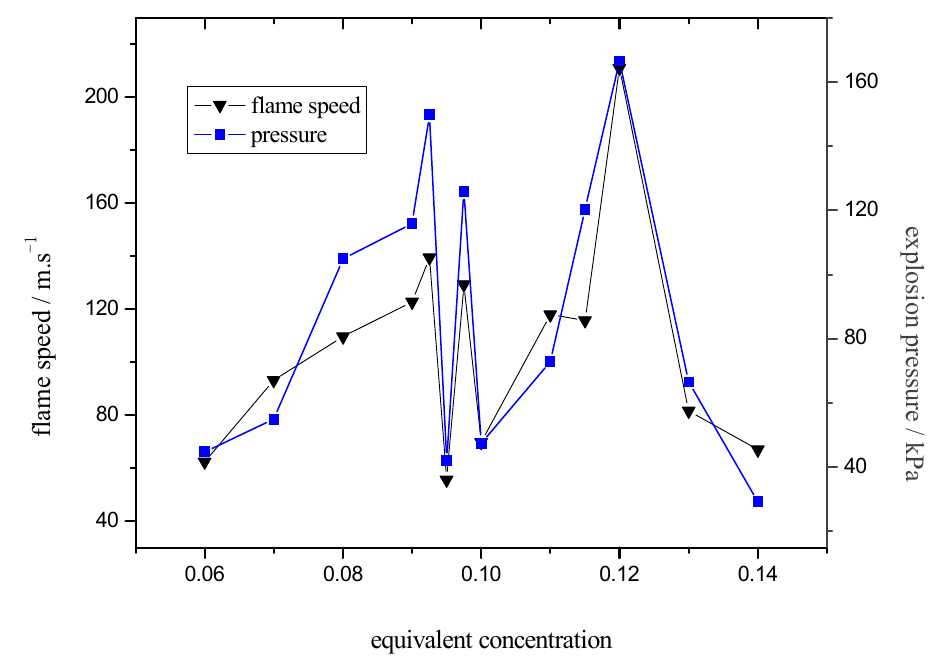
Figure 5. Explosion pressure and flame speed in the turbulent